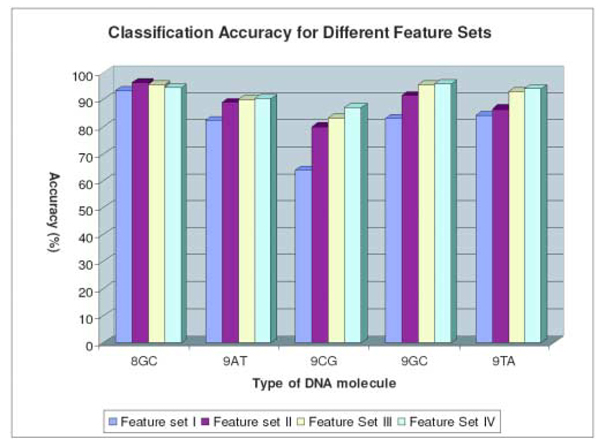
Classification Results for four different datasets used in boosting with stumps approach.